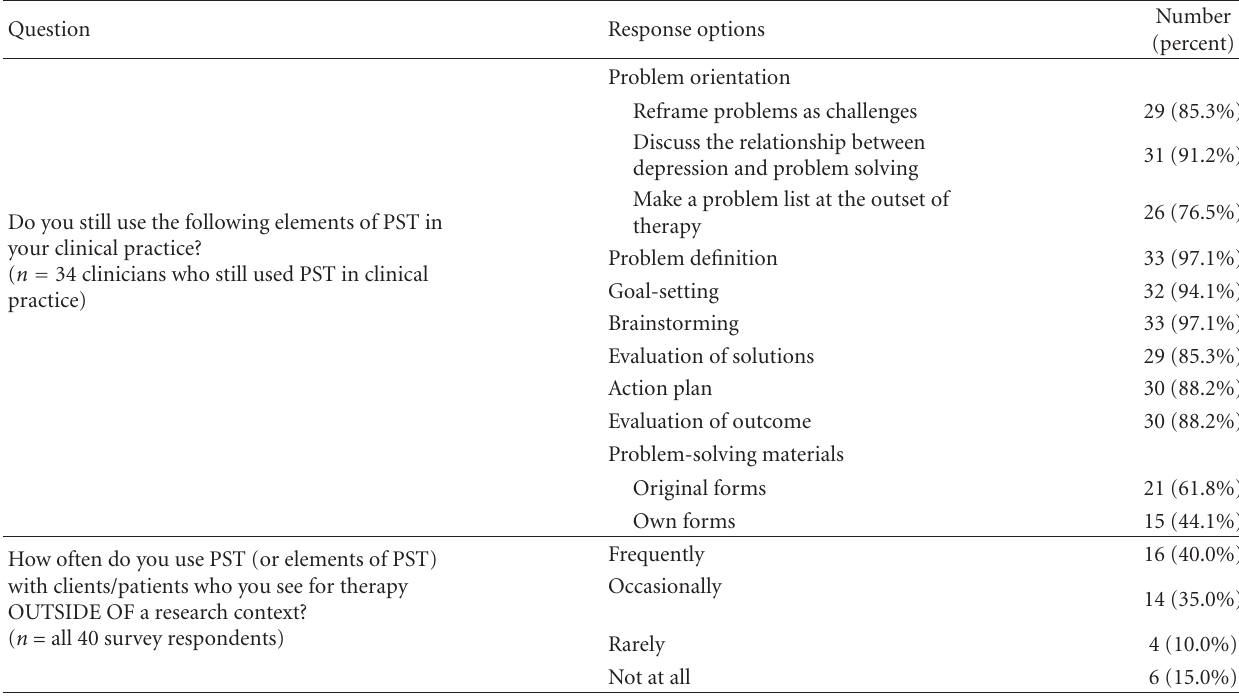
Table 2: Survey respondents’ current use of PST in clinical